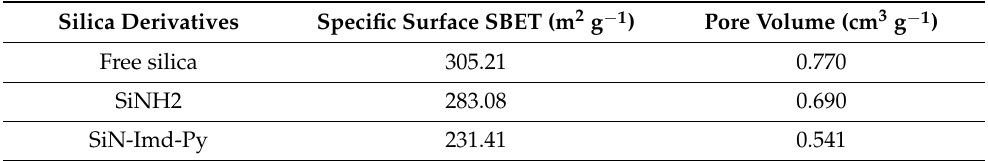
Table 2. Physical Properties of Silica Derivatives.